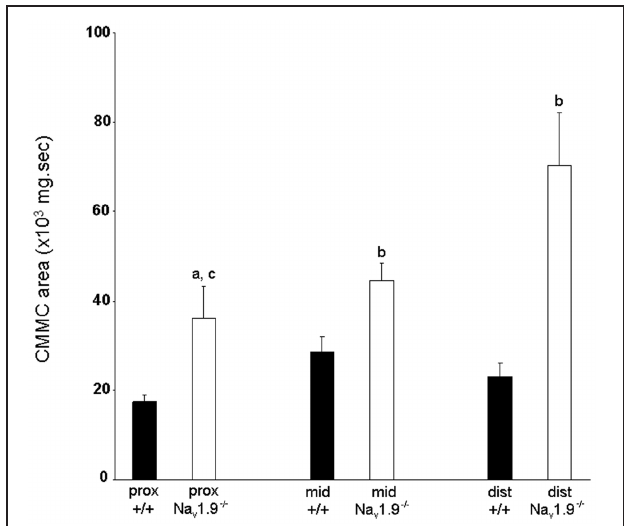
FIGURE 5 | Graphic representation of the area of CMMCs in the proximal, mid- and distal colon of wild-type and Na v 1.9 − / − mice. The area of CMMCs in Na v 1.9 − / − mice was found to be significantly larger than in + / + mice. In Na v 1.9 − / − mice, the area of CMMCs in the proximal colon was significantly smaller than in the distal region. a P < 0 . 05, b P < 0 . 01 vs. + / + mice; c P < 0 . 01 proximal vs. distal colon in Na v 1.9 − / − mice.